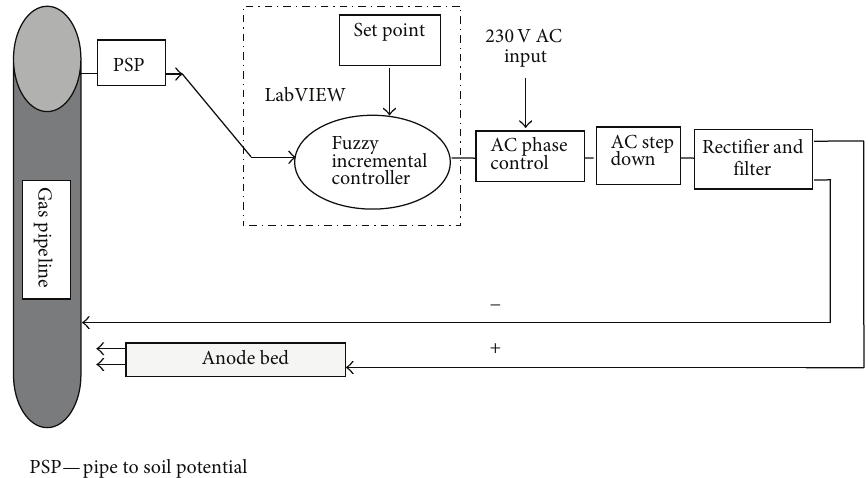
Figure 2: Schematic diagram of impressed current cathodic protection.